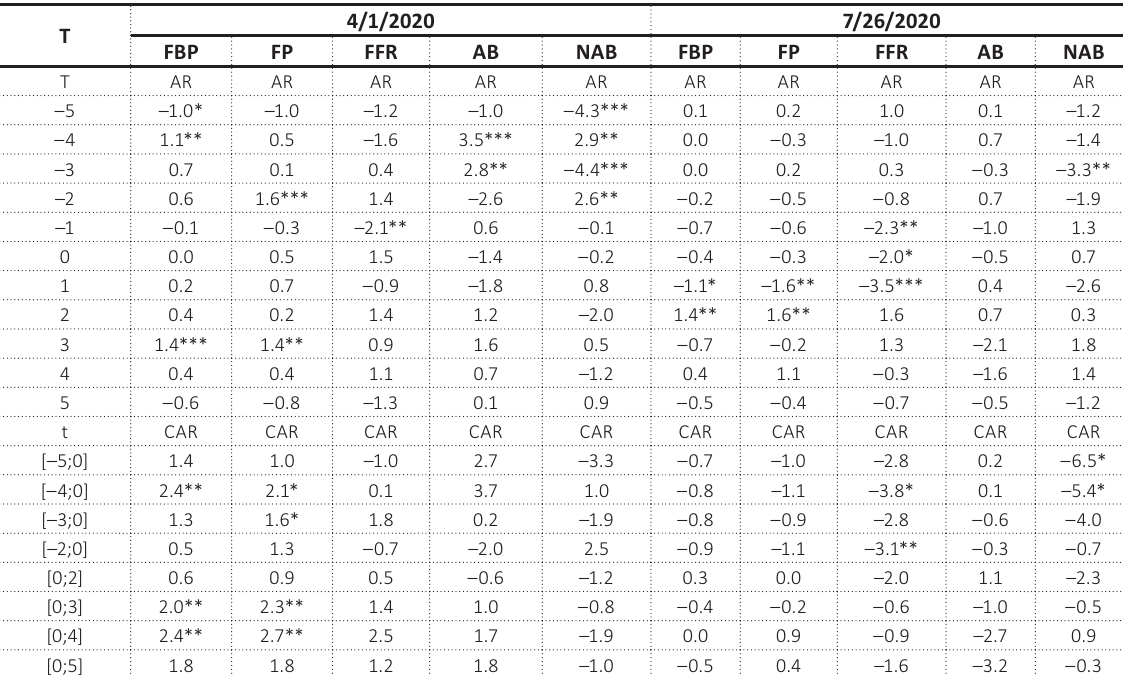
Table 3. Abnormal return (AR) and cumulative abnormal return (CAR) of the food and